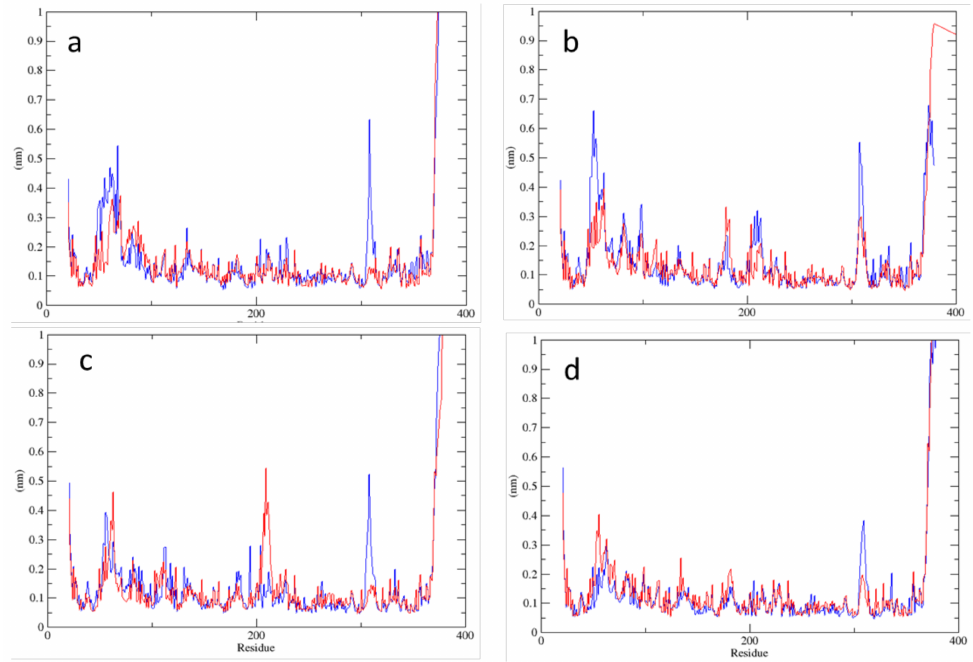
Figure 7. RMSF analysis. Simulations with arginine in the central cavity. ( a ) wtGALT + arginine; ( b ) p.Gln188Arg + arginine; ( c ) wtGALT + G1P + H2U + arginine; ( d ) p.Gln188Arg + G1P + H2U + arginine. Blue lines represent RMSF fluctuation of chain A; red lines, that of chain